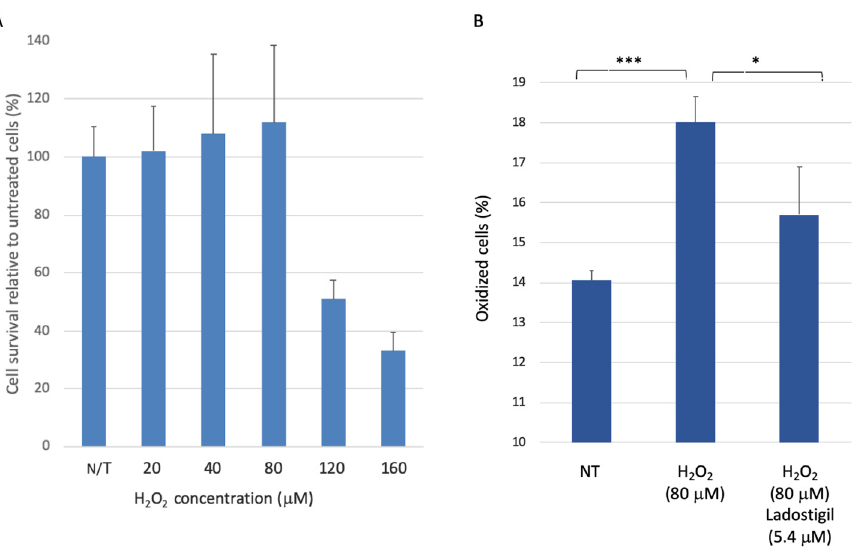
Figure 1. SH-SY5Y cells under acute oxidation stress and ladostigil treatment. ( A ) Cell viability with increasing concentrations of hydrogen peroxide (H 2 O 2 ) was analyzed after 24 h by MTT assay. ( B ) Cells transfected with a mix of plasmids carrying sensors for redox state (see Materials and Methods) were analyzed by FACS. The cells were exposed to H 2 O 2 for 3 h with or without pre-incubation (for 2 h) with ladostigil. In each experiment, the fraction of oxidized cells is determined relative to the untreated cells. Each group represents biological triplicates. The statistical test ( t -test) showed significance at the level of <0.05 (*) and <0.001 (***).